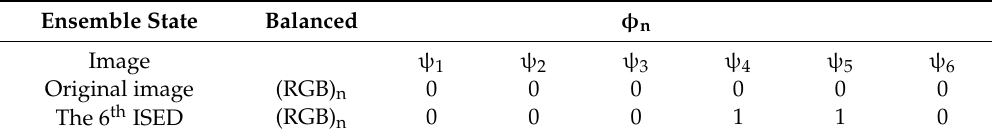
Table 1. Balanced state ensemble of the sixth ISED generated image (seen in Figure 2b). RGB: red, green, and blue.